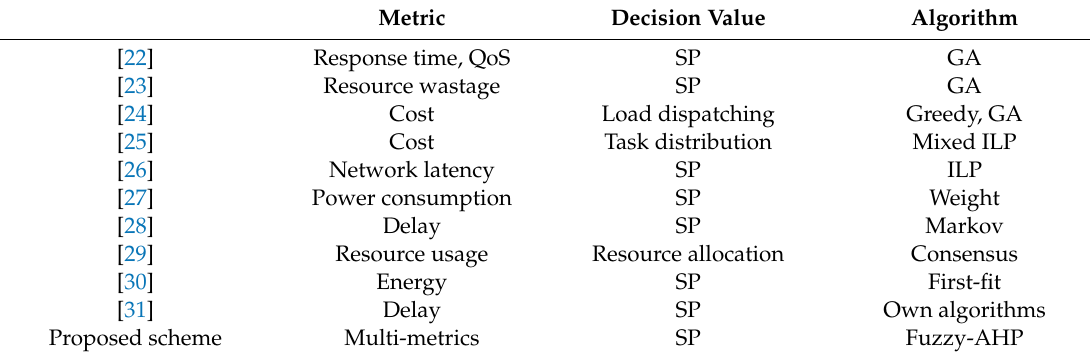
Table 2. Related work on